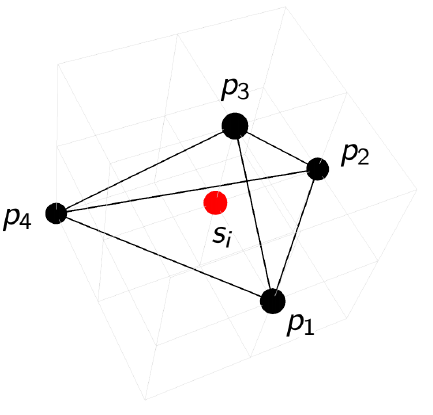
Figure 11 . Toric diagram for Model 1.